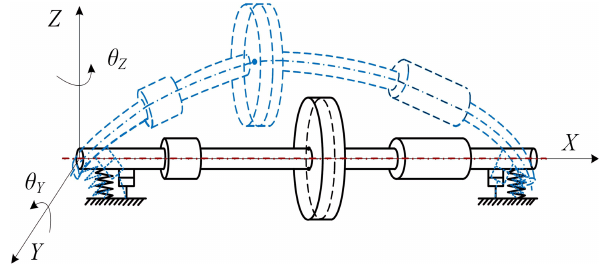
Figure 1. Structural diagram of the rotor system.